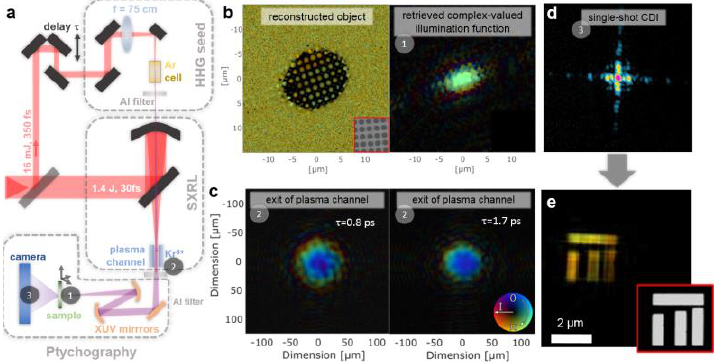
Fig. 1. Ptychographic characterization of a HHG-seeded SXRL. (a) Experimental scheme for ptychographic characterizing the beam of a HHG-seeded SXRL in amplitude and phase and single- shot ultrafast imaging (the plasma channel is created by another, for clarity not shown, arm of the same input laser). (b) Reconstruction of a microscopic object imaged by ptychography (inset shows SEM image of the sample used for ptychography) and reconstructed complex-valued illumination function at the sample. (c) Examples of measured normalized complex-valued SXRL beam profiles at the exit of the plasma channel for two different time delays between SXRL pump and HHG seed as indicated. (d) Measured single shot coherent diffraction pattern and (e) reconstruction of the object with ~100 nm resolution (inset shows SEM image of the sample used for single shot measurements). All panels except (d) show complex-valued spatial representations where the amplitude and phase are encoded by brightness and hue as indicated in right panel in